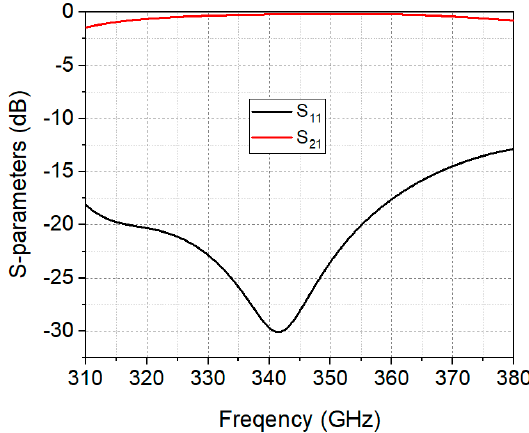
Figure 6. ( a ) Vacuum model of TE 10 -TE 30 convertor. ( b ) Electric field of TE 10 -TE 30 convertor.